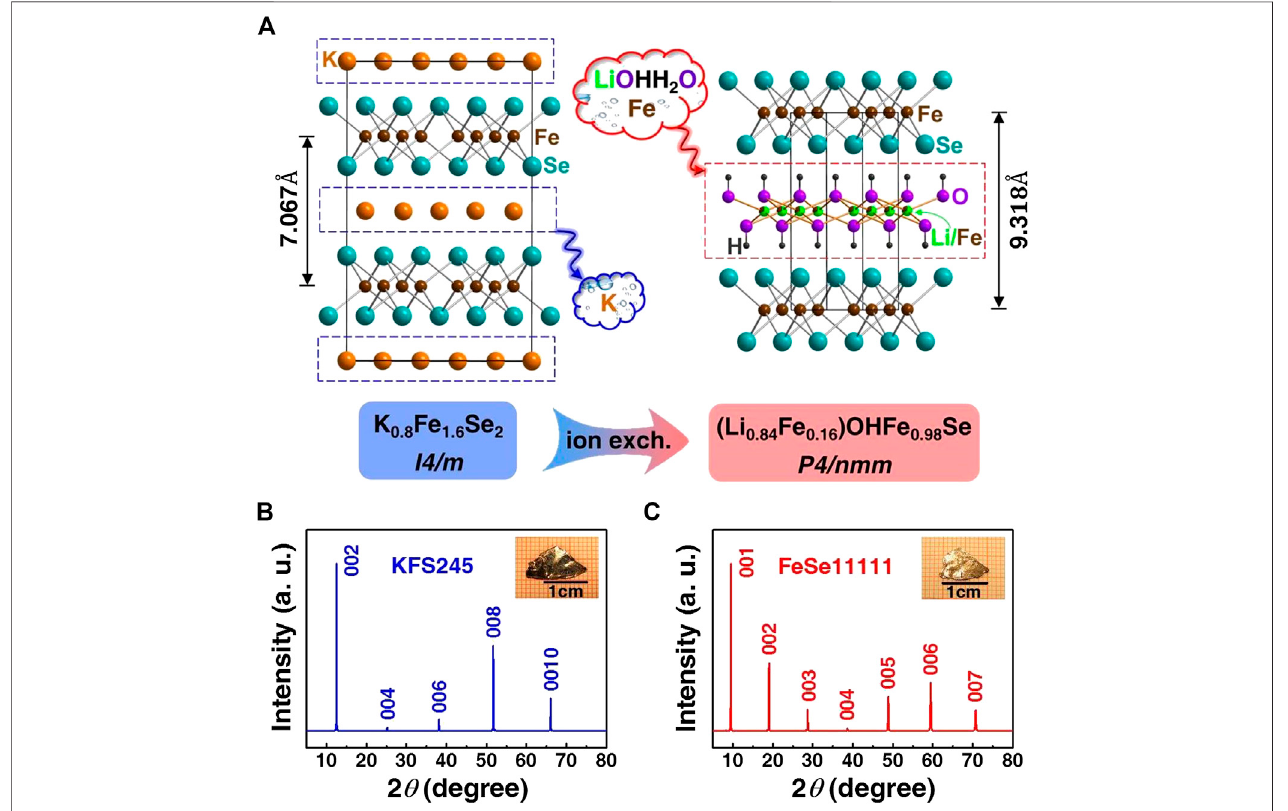
FIGURE 1 | Illustration of hydrothermal ion-exchange growth of (Li,Fe)OHFeSe crystals [58].